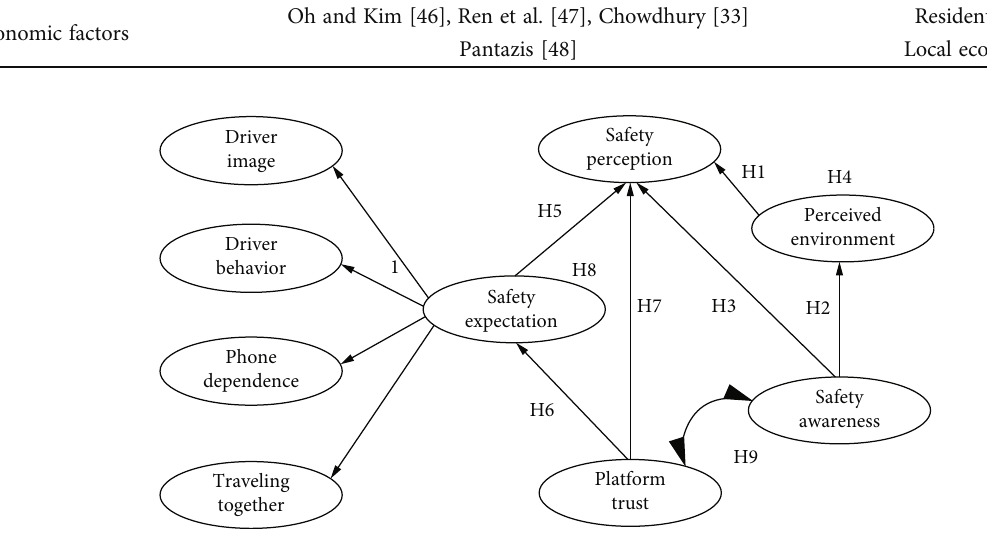
Figure 2: The hypothesized